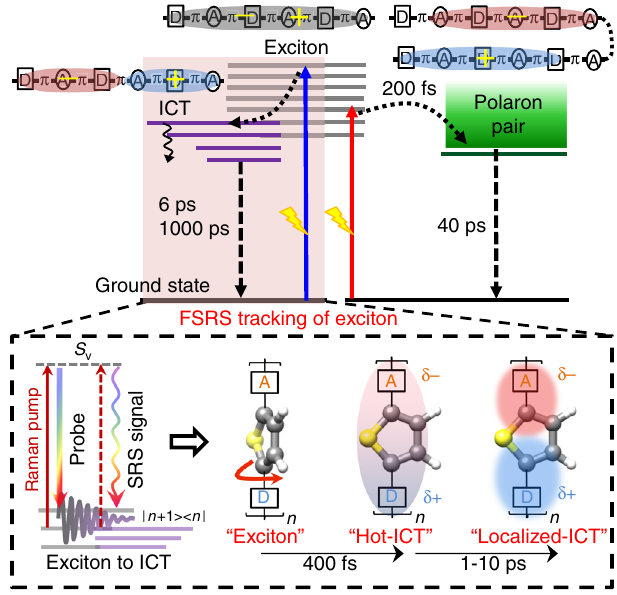
Fig. 6 Schematic of the exciton dynamics and its driving molecular coordinates. FSRS measurements directly probe the exciton relaxation via thiophene bridge planarization leading to hot delocalized ICT character, and its subsequent cooling